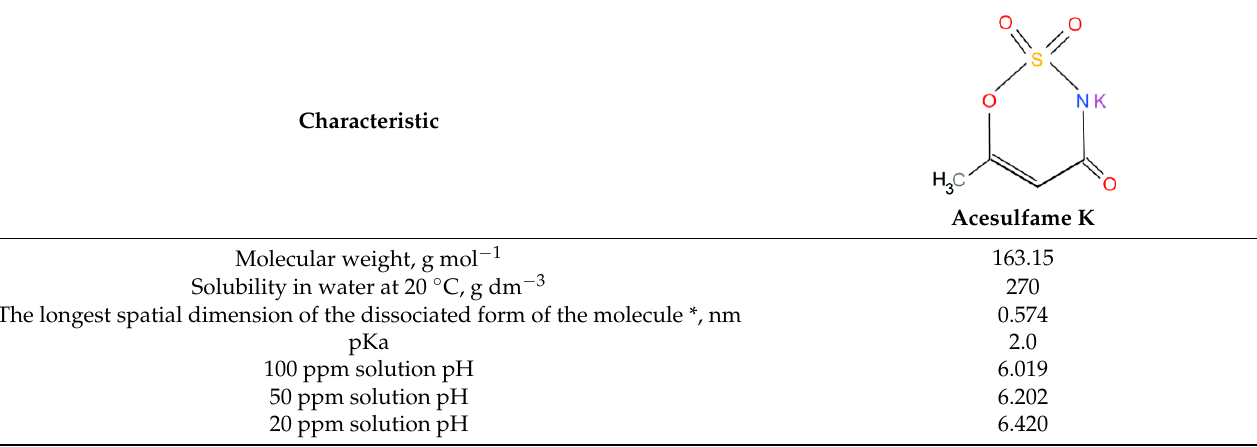
Table 2. Physicochemical properties of the Acesulfame K.